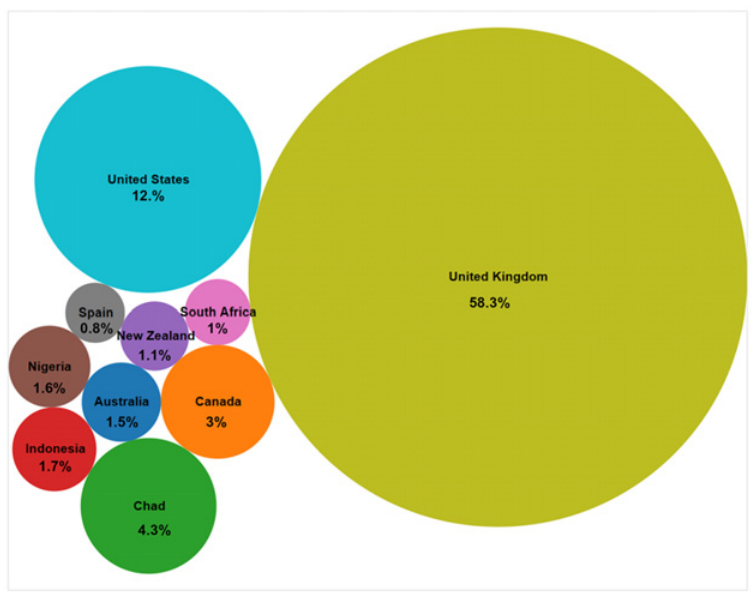
Fig 4. Share of tweets that refer to London ’ s homicide news among different